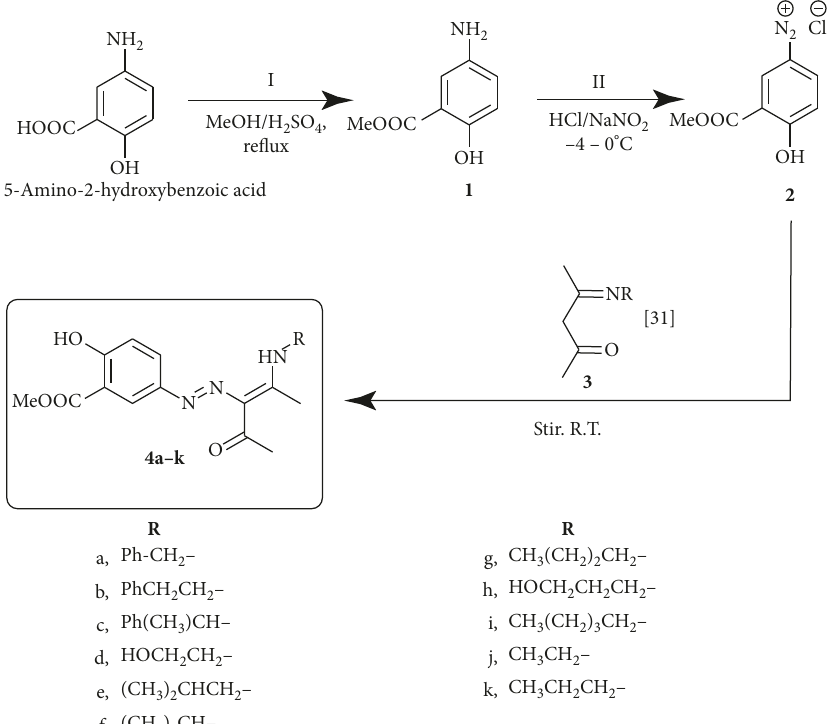
Scheme 1: Synthetic route of compounds 4a–k